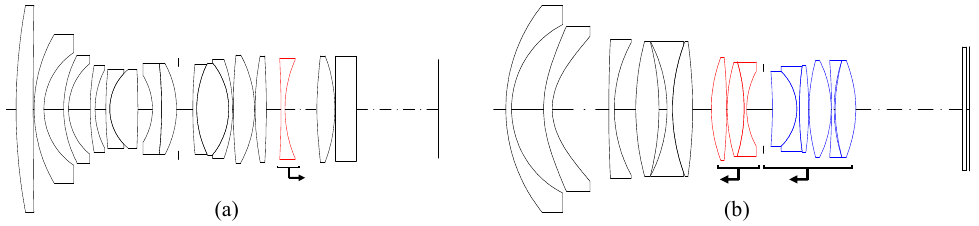
Figure 1. Layout of ( a ) inner focus system [12] and ( b ) floating system [13].